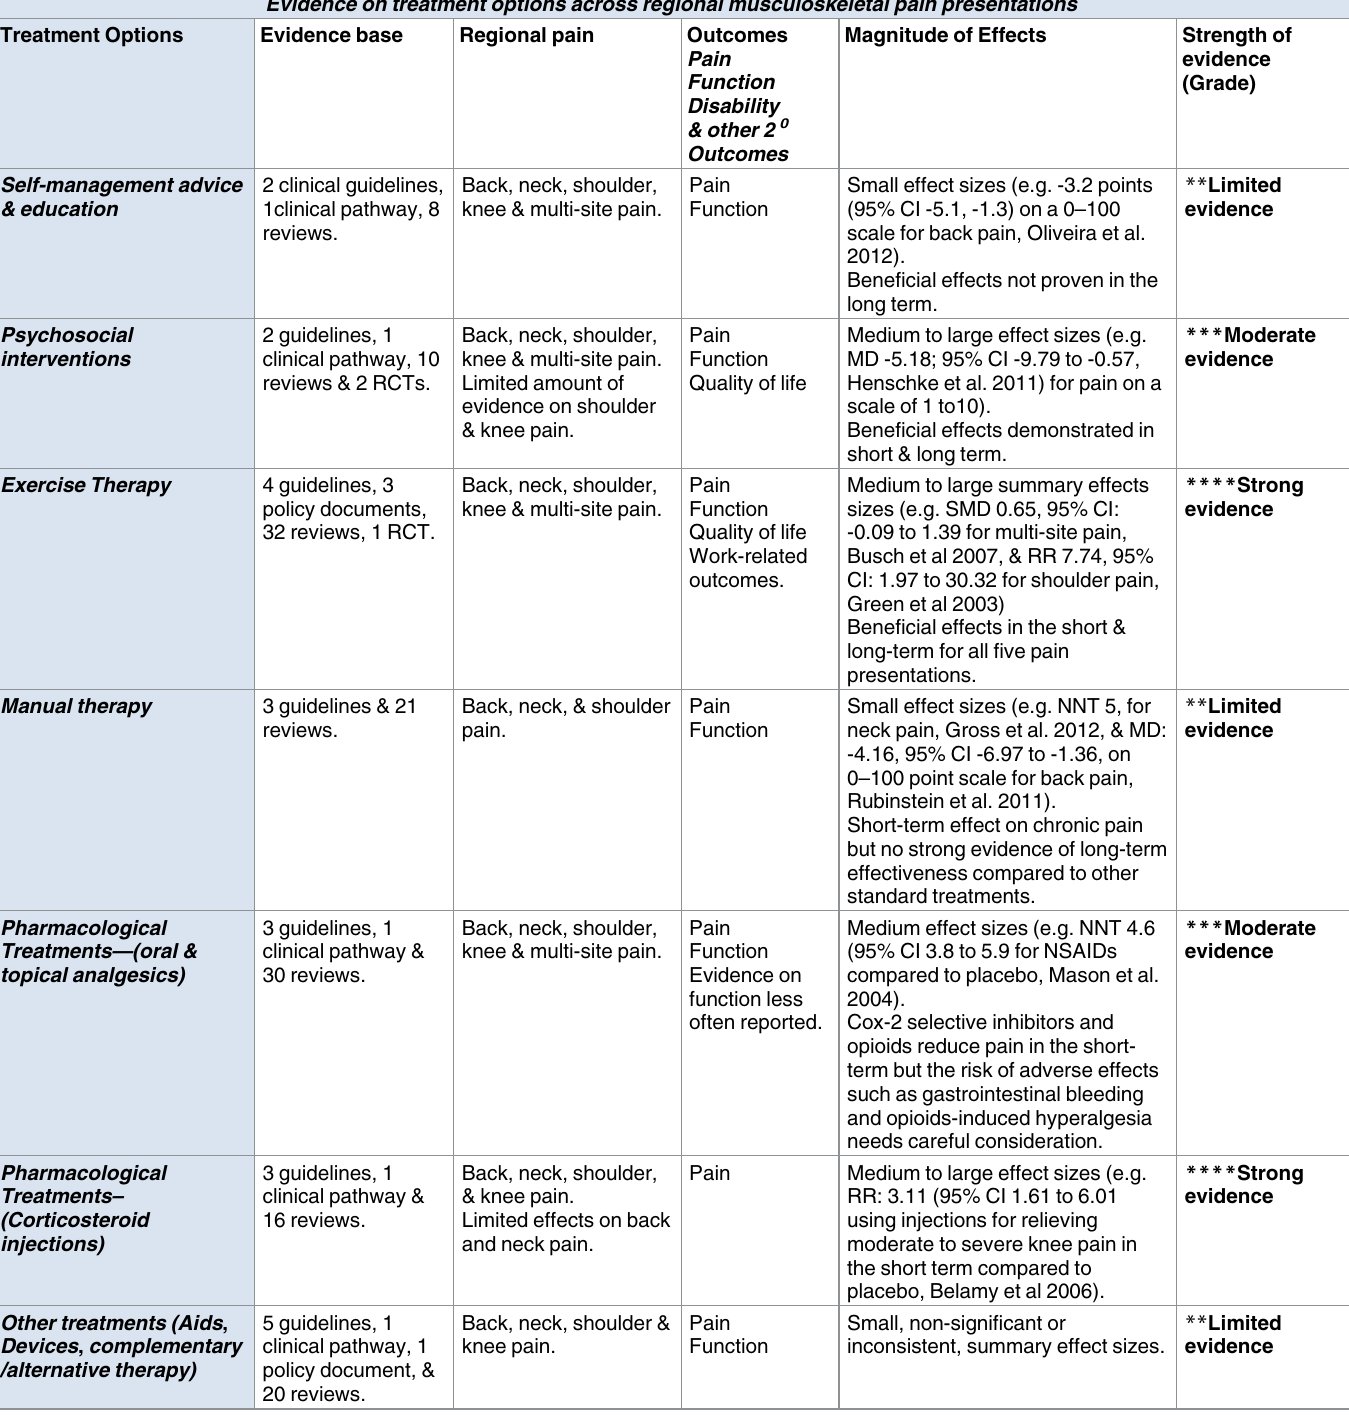
Table 1. Summaryof